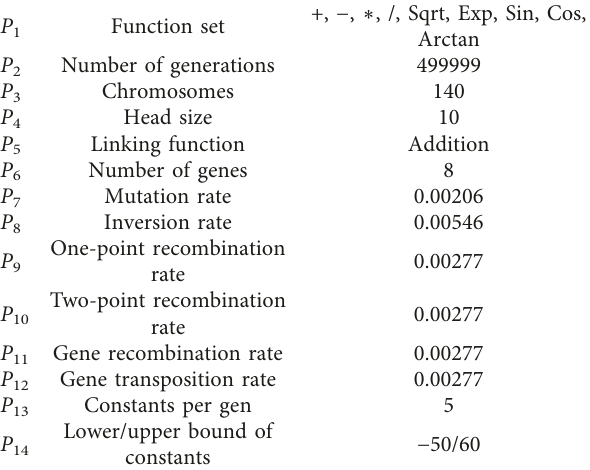
Table 3: The parameters used in the proposed